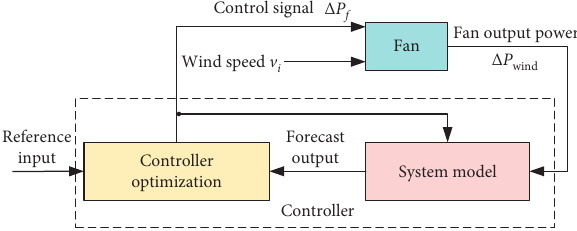
Figure 4: Flow chart of the model predictive control method for active frequency control of wind